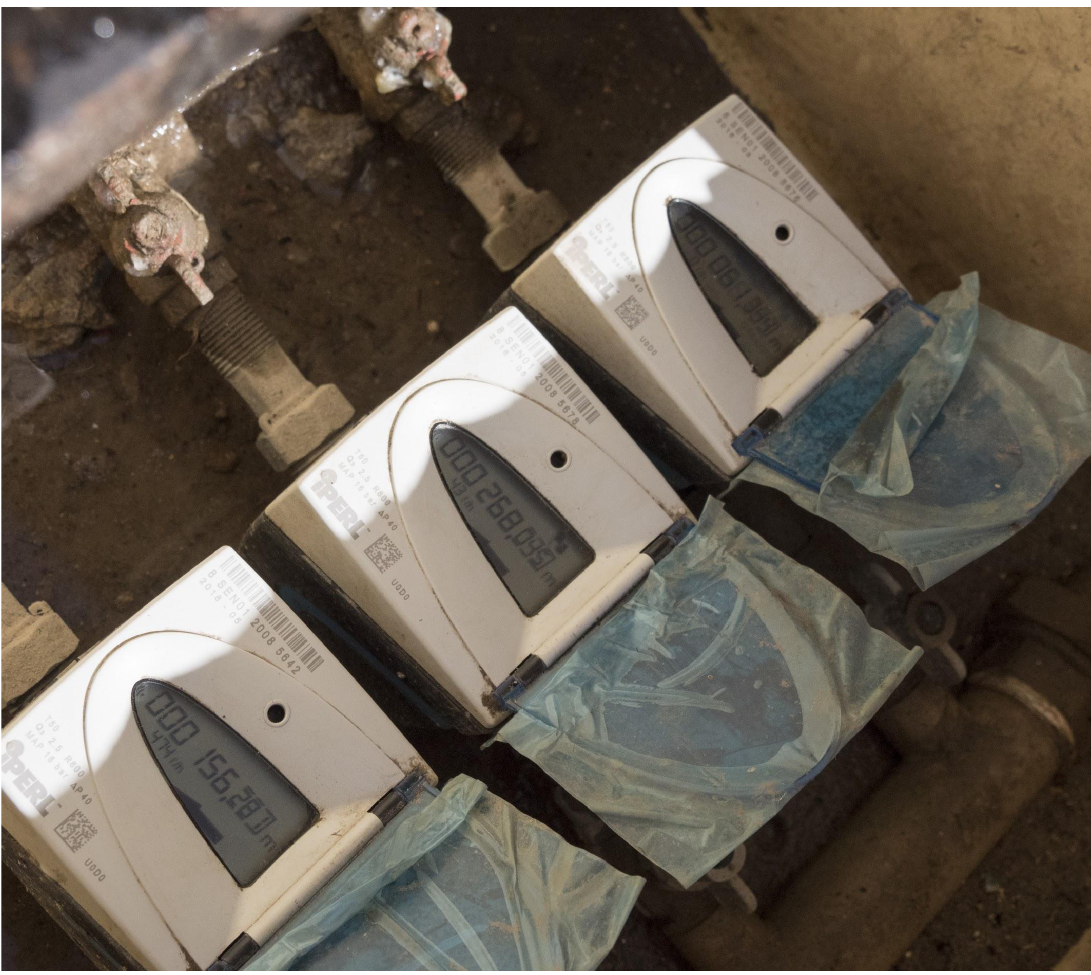
Figure 7. Example of an inspection pit in Gorino Ferrarese,